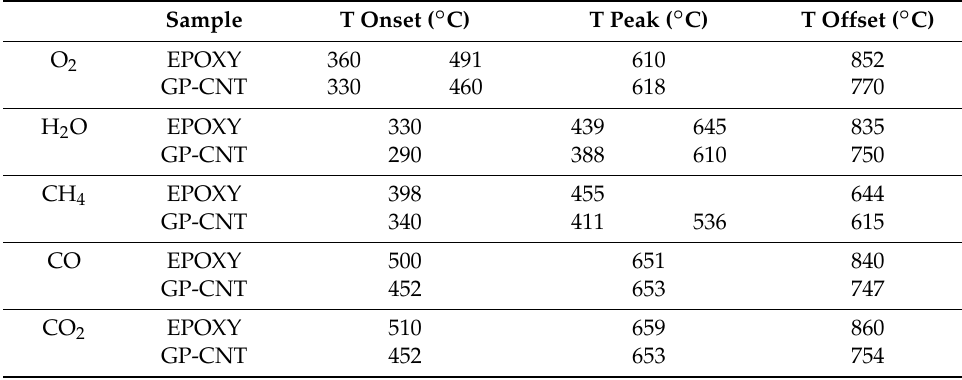
Table 4. Onset temperatures, temperatures at the peak, and offset temperatures for the concentration of the oxygen and for the released compounds during the combustion.